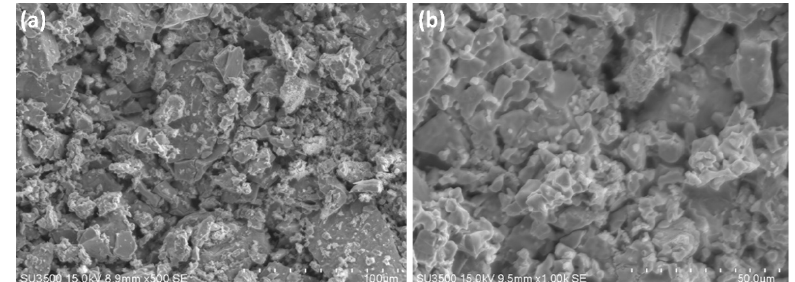
Figure 3. Surface morphology of the ( a ) MMC and ( b ) the fracture surface MMC.